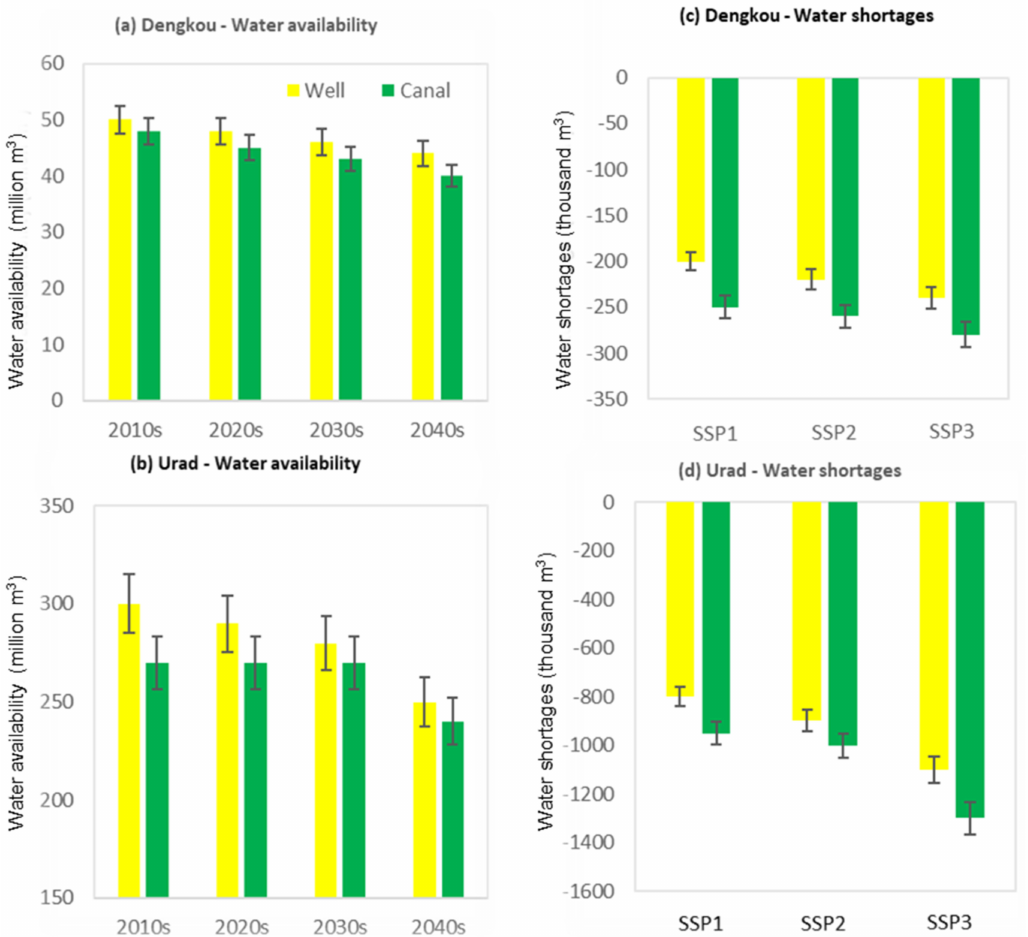
Figure 7. Annual average water availability of two irrigation methods in two irrigation areas ( a , b ) and annual average water shortage from 2010 to 2050 under the SSPs ( c , d